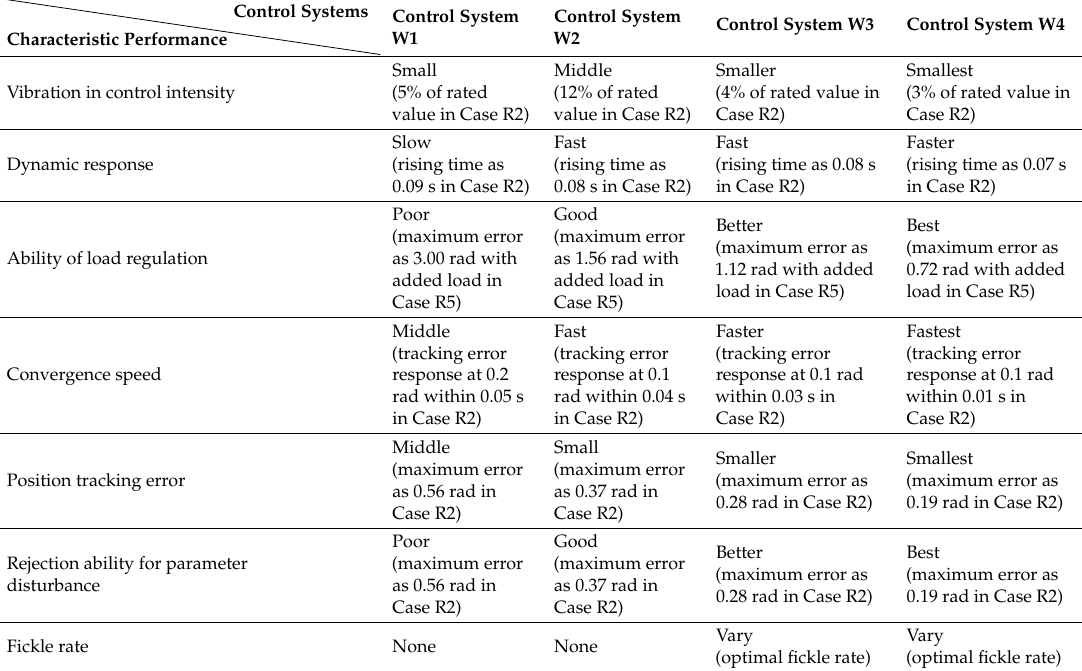
Table 2. Control characteristic performance comparisons of control